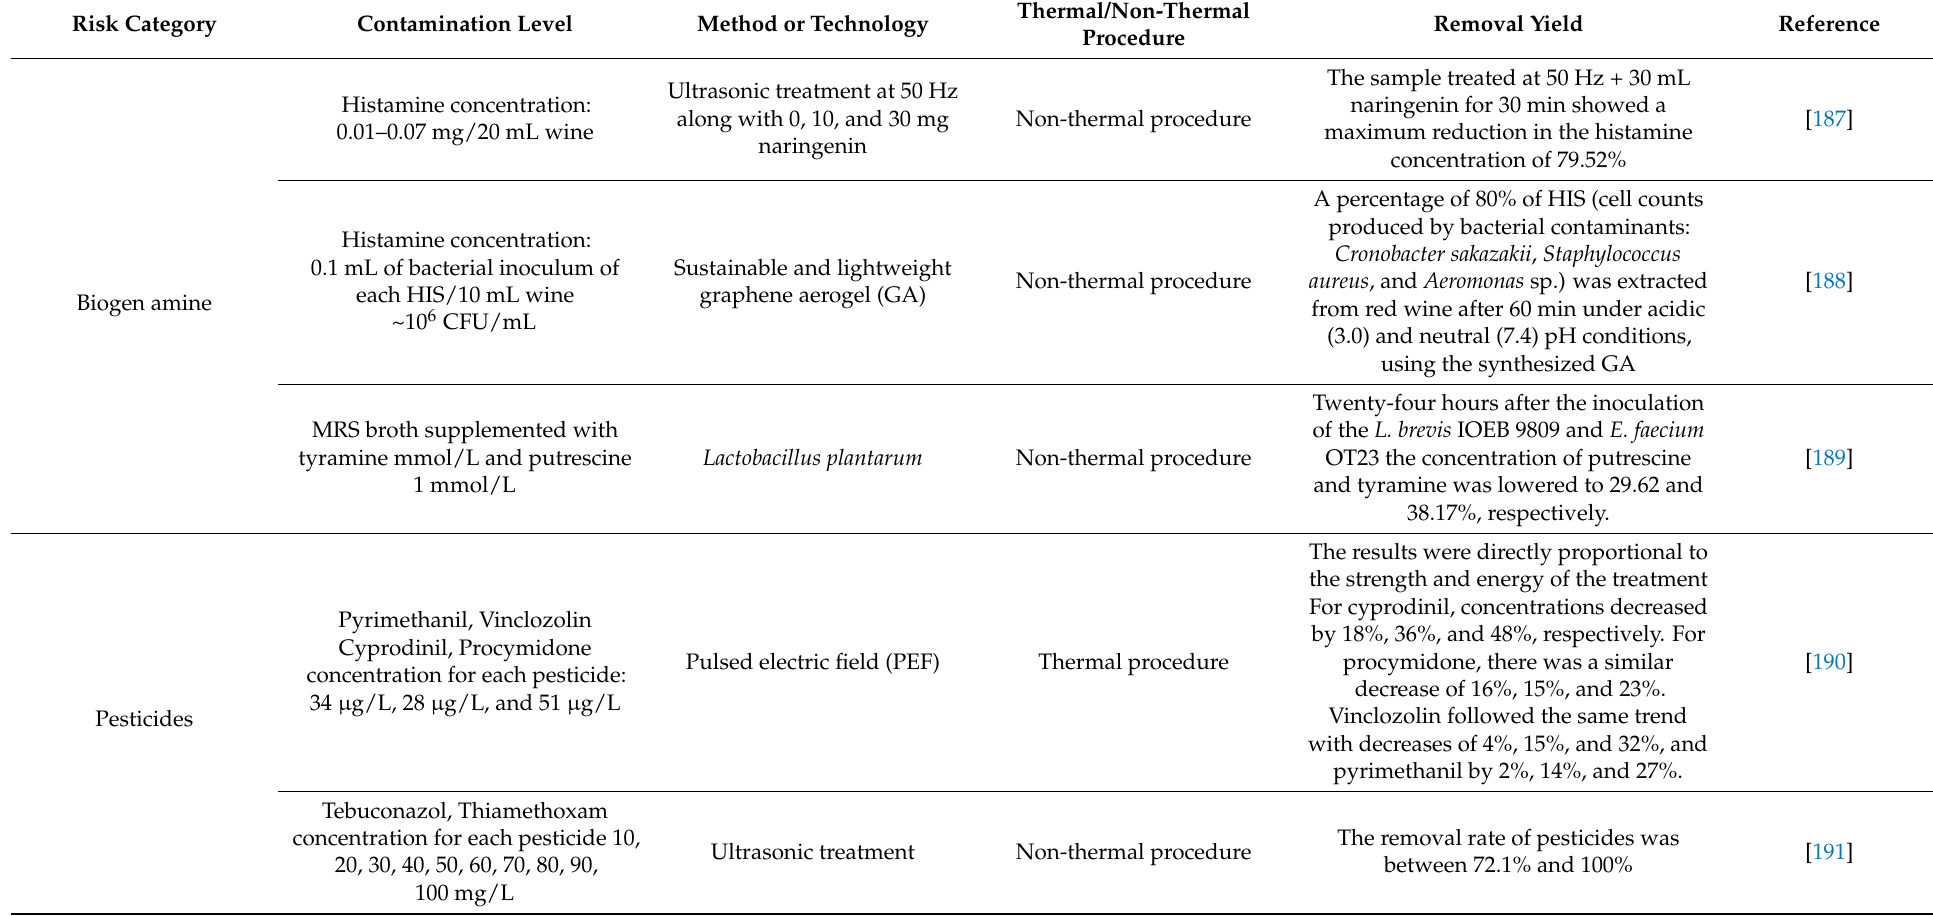
Table 1. Application of removal techniques for chemical contaminants in fermented fruit-based